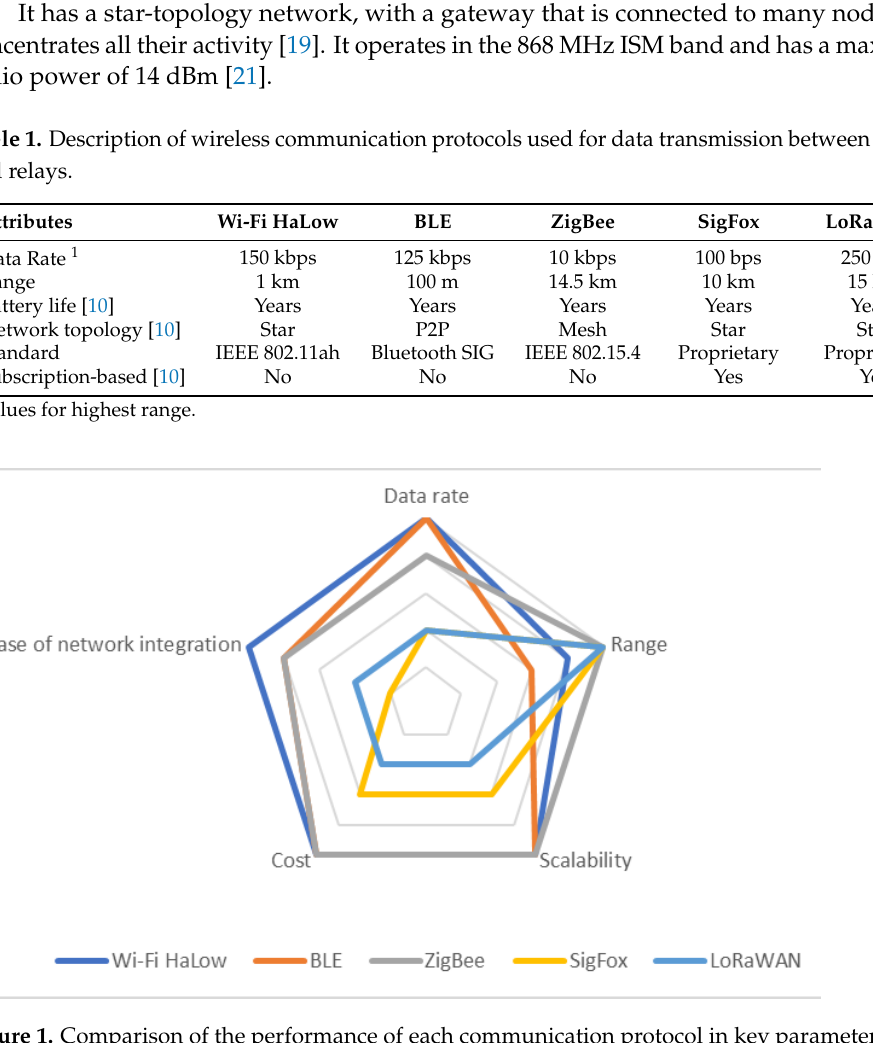
Table 1. Description of wireless communication protocols used for data transmission between sensors and relays.